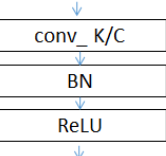
Figure 6. Structure of conv_i.